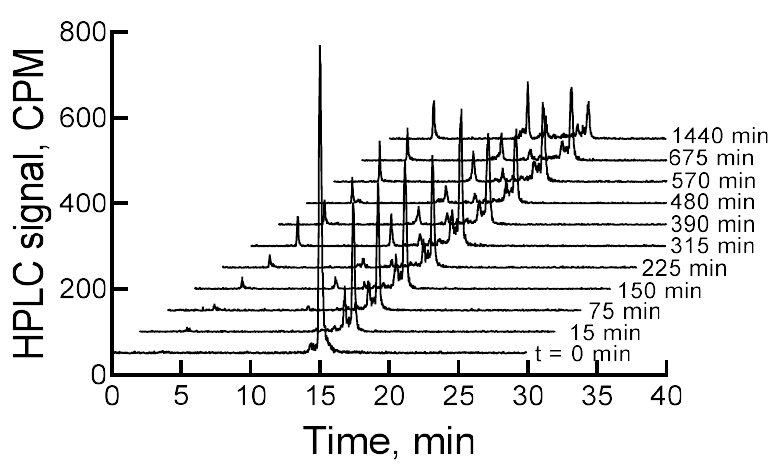
Figure 5. HPLC chromatograms of 177 Lu-labeled RM1 in mouse serum at 37 °C as a function of incubation time over 24 h.